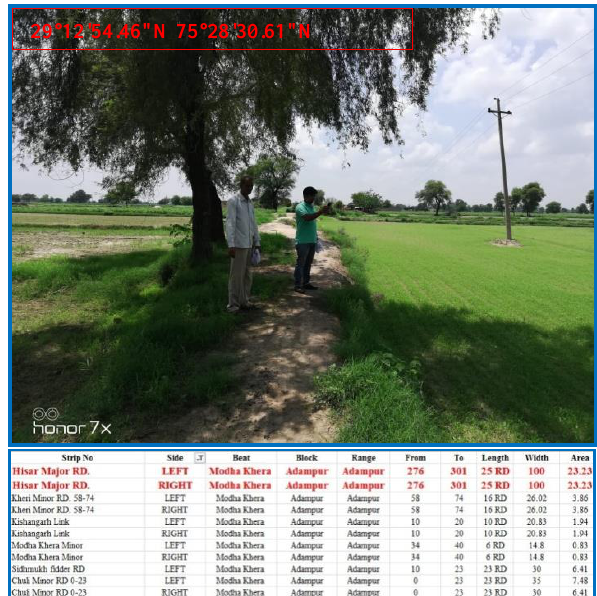
Photo 1. Hisar Major Canal (Modha Khera Beat) mentioned in notification, not present on